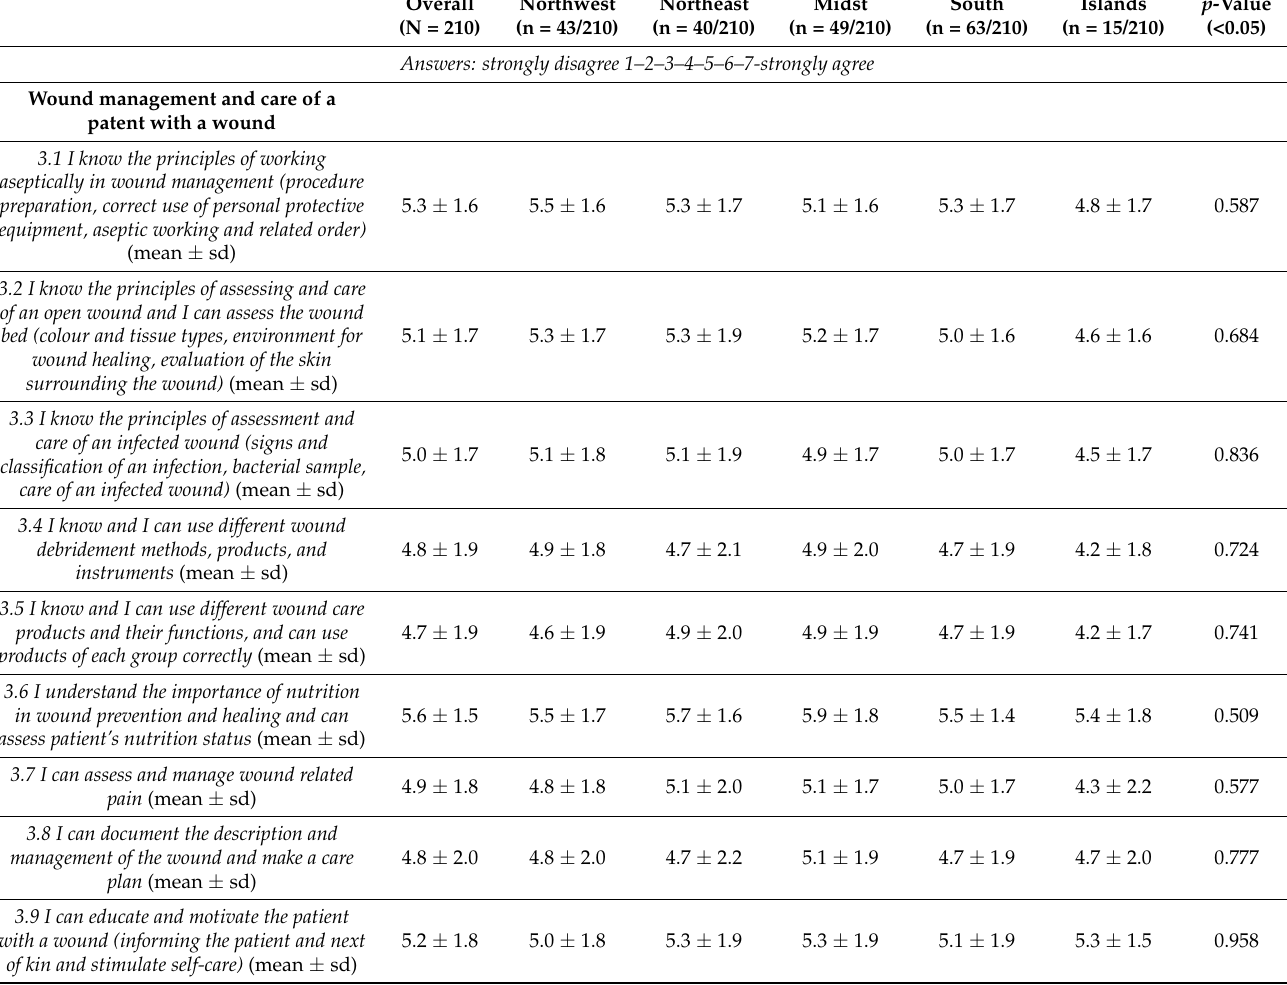
Table 6. Competence area in wound care: wound management and care of a patent with a wound. Each query expects a score value as an answer, based on a seven-point scale (Likert scale) ranging from 1 (strongly disagree) to 7 (strongly agree). Results are shown as mean ± standard deviation (mean ± sd). Overall Northwest Northeast Midst South Islands (N = 210) (n = 43/210) (n = 40/210) (n = 49/210) (n = 63/210) (n = 15/210)